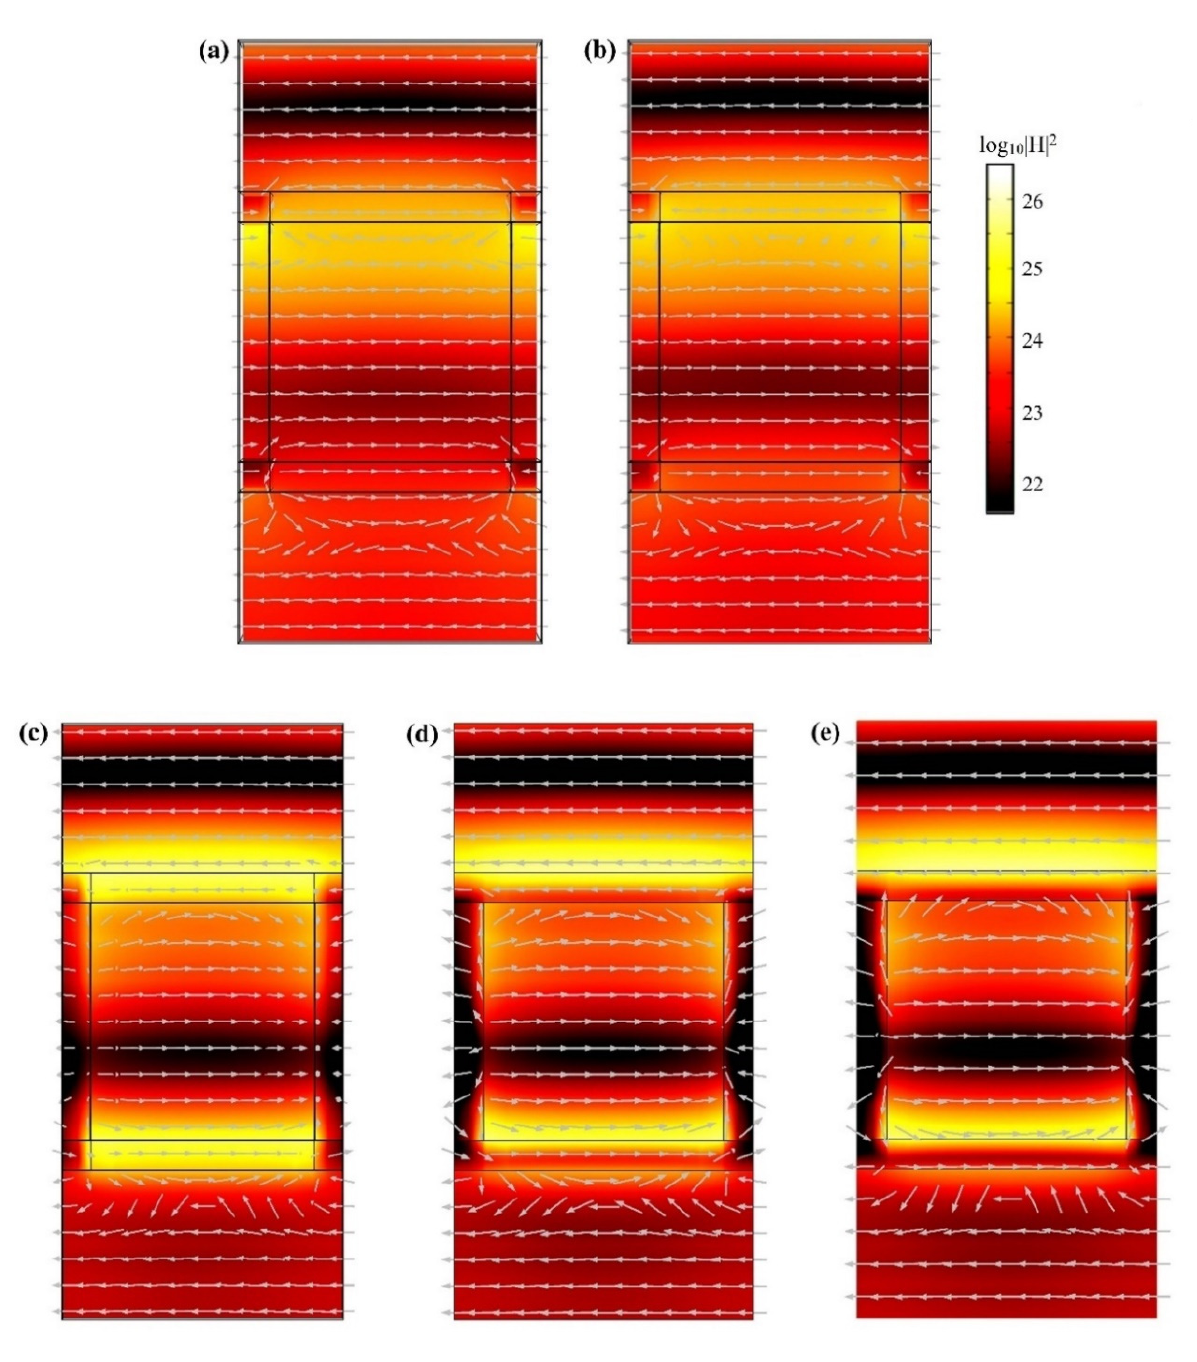
Figure 8. Magnetic and electric fields intensity distribution at the different compute region at the wavelength of 0.96 µ m: ( a ) Y = 0 nm, ( b ) Y = 100 nm, ( c ) Y = 200 nm, ( d ) Y = 225 nm, ( e ) Y = 250 nm.